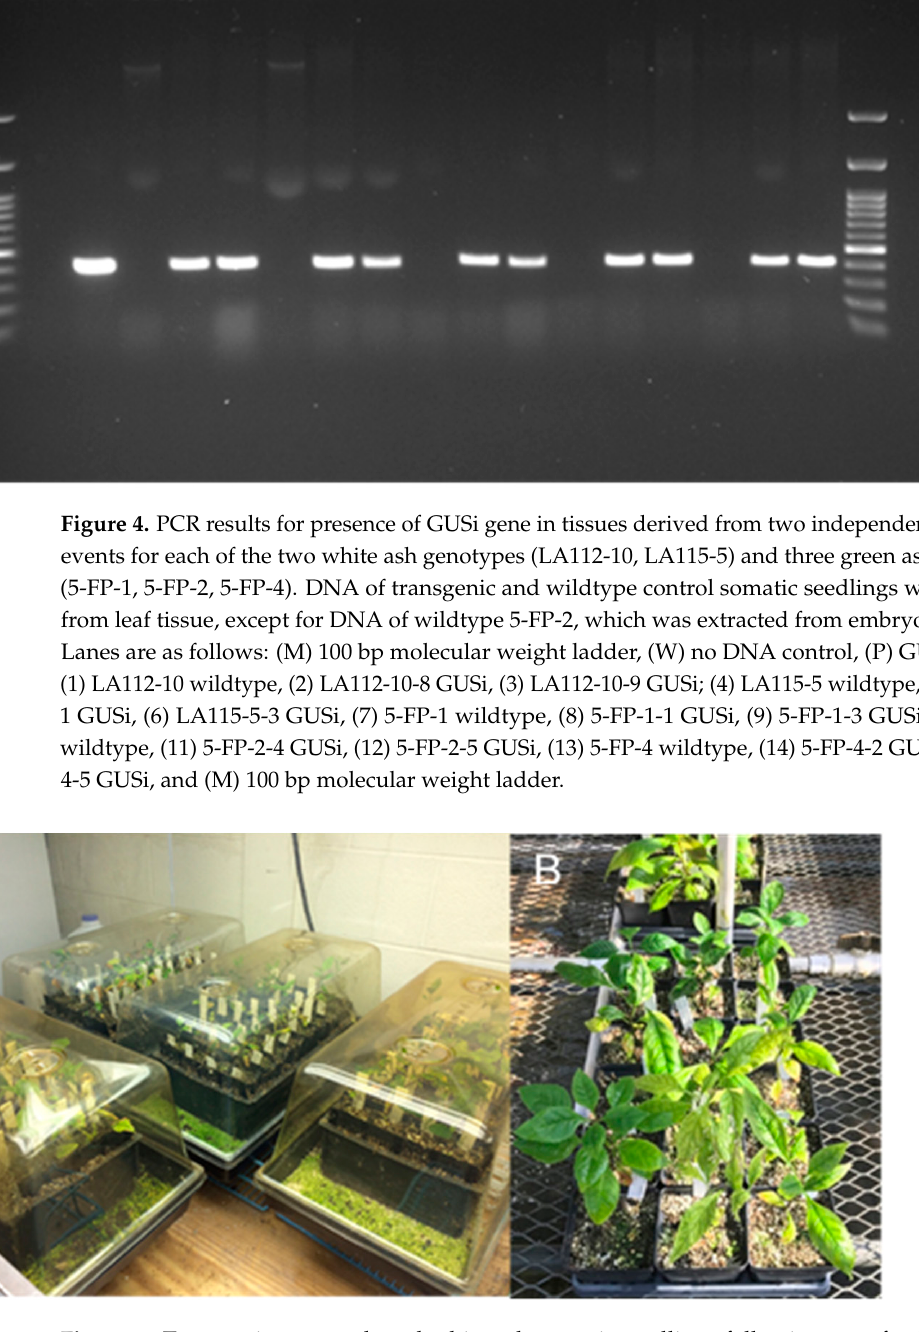
Figure 5. Transgenic green ash and white ash somatic seedlings following transfer from in vitro conditions. ( A ). Transgenic ash somatic seedlings following transfer to potting mix in domed trays for acclimatization. ( B ). Acclimatized transgenic ash somatic seedlings in the greenhouse.